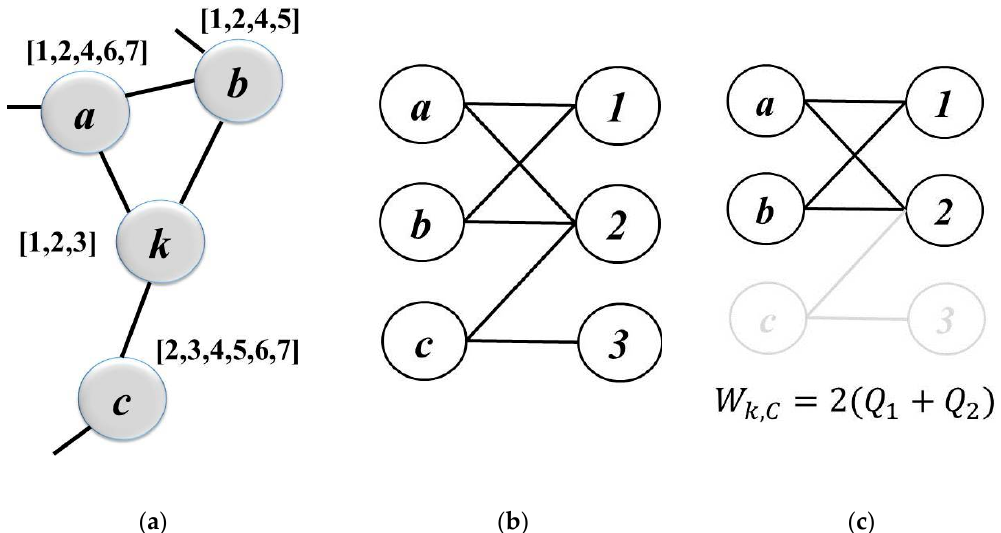
Figure 1. An example of calculations for the spectrum-aware weight of cognitive sensor (CS) k : ( a ) a four-node fragment of the Cognitive Radio Sensor Network (CRSN) topology; ( b ) the bipartite graph for CS k ; and ( c ) the maximum edge biclique and weight of CS k in terms of spectrum availability.